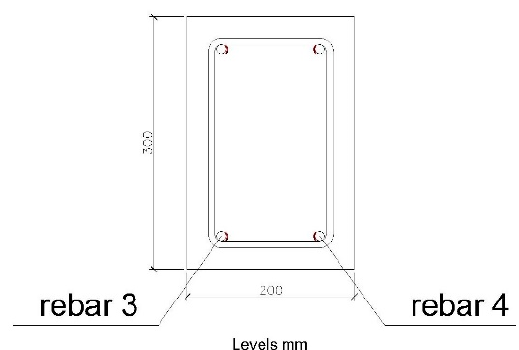
Figure 13. Position of the rebars studied in the 200 × 300 mm beam.